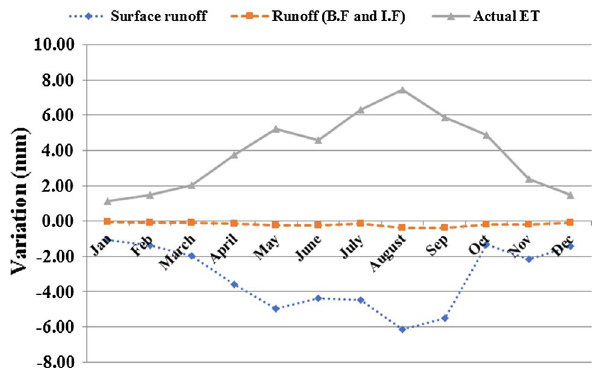
Fig. 12 Change in hydrological components in Kase River after 100 years under CC-scenario